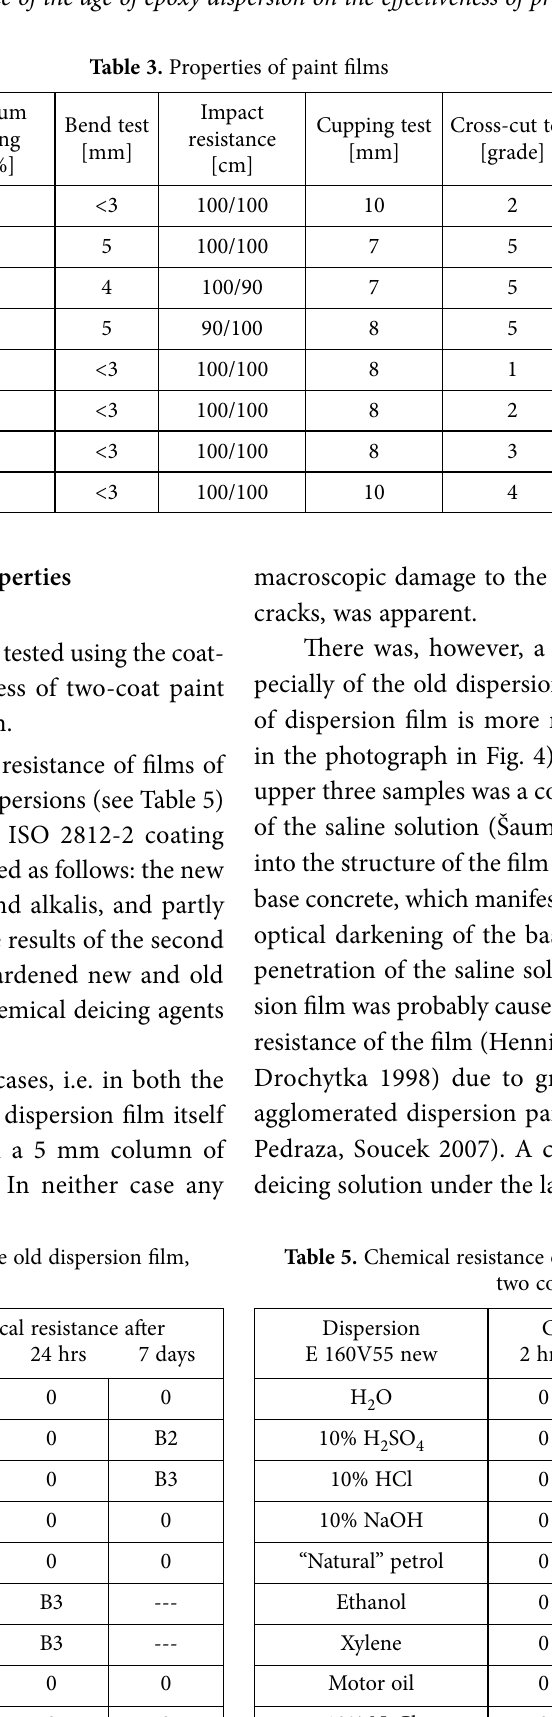
Table 4. Chemical resistance of the old dispersion film, two